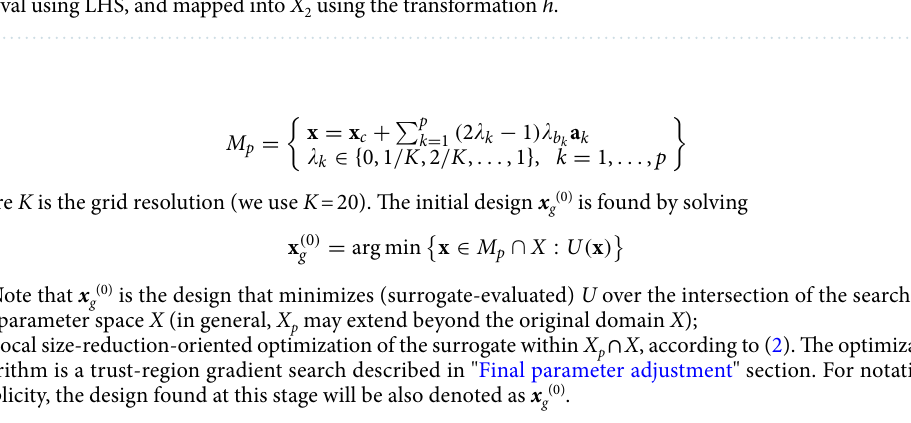
Figure 5. Design of experiments (data sampling) in reduced-dimensionality domain (here, two dimensional): ( a ) sampling procedure, ( b ) graphical illustration: normalized samples are uniformly distributed in the unity interval using LHS, and mapped into X 2 using the transformation h